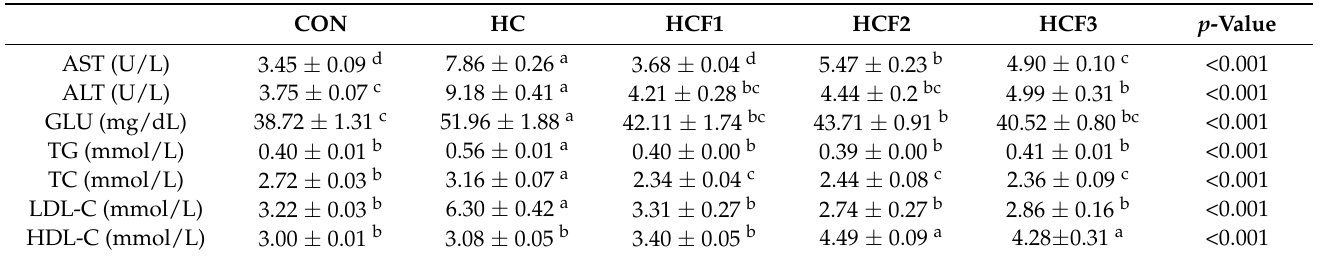
Note: In the same row, values with different small letter superscripts mean significant difference ( p Table 4. Effects of dietary mulberry leaf flavonoids on serum biochemical indices of rice field eel ( Monopterus albus ) fed high-carbohydrate diets (mean ± S.E.).